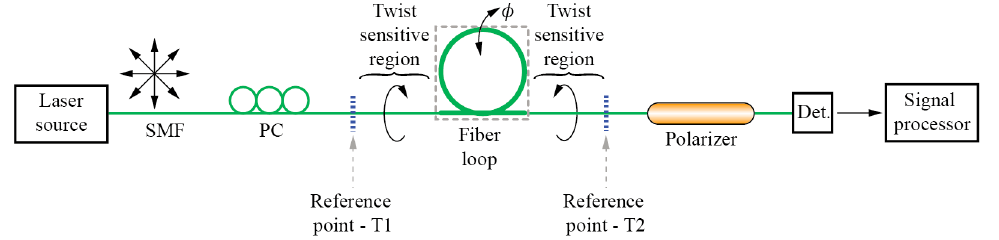
Figure 2. Fiber loop sensor system for angular measurements.